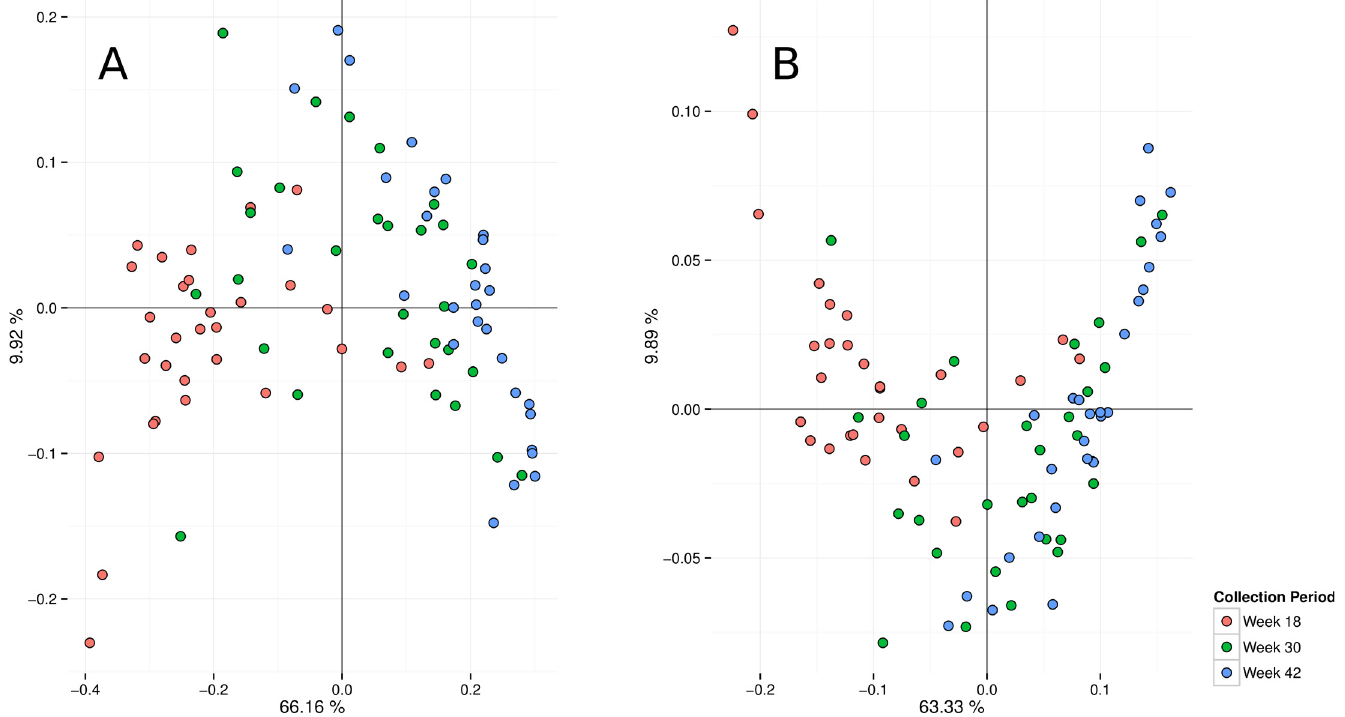
Fig 2. Principal coordinates analysis (PCoA) of microbiome taxonomy and function. Analyses of genus (a) and KEGG ortholog group data (b) indicated a structure based on age (weeks).